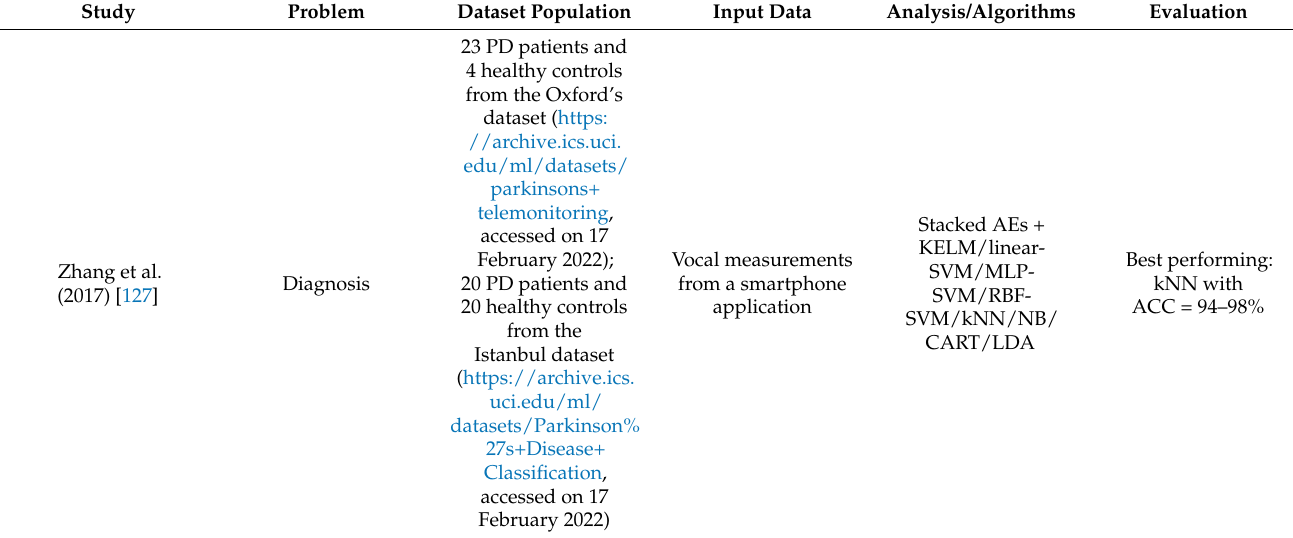
Table A4. Studies based on voice or audio